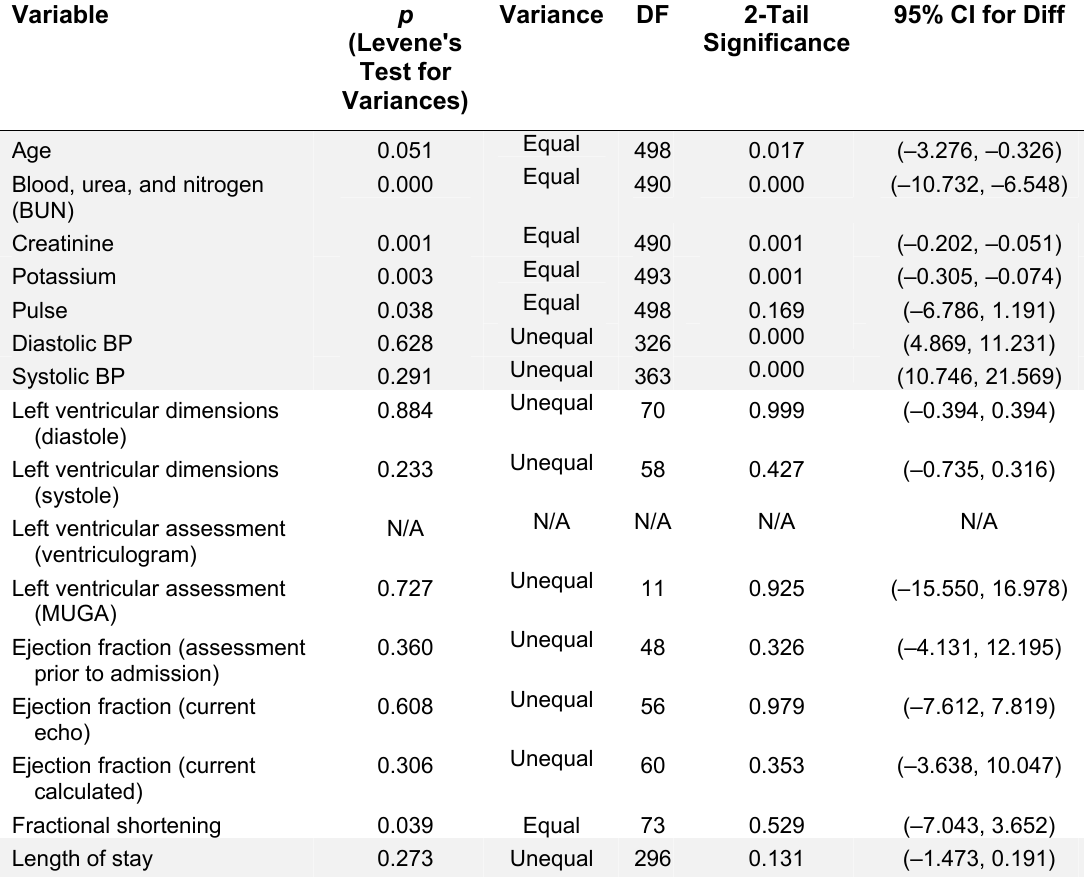
Mortality within 360 Days of Discharge Student t Test for Independent Samples Shaded Area: Variables of